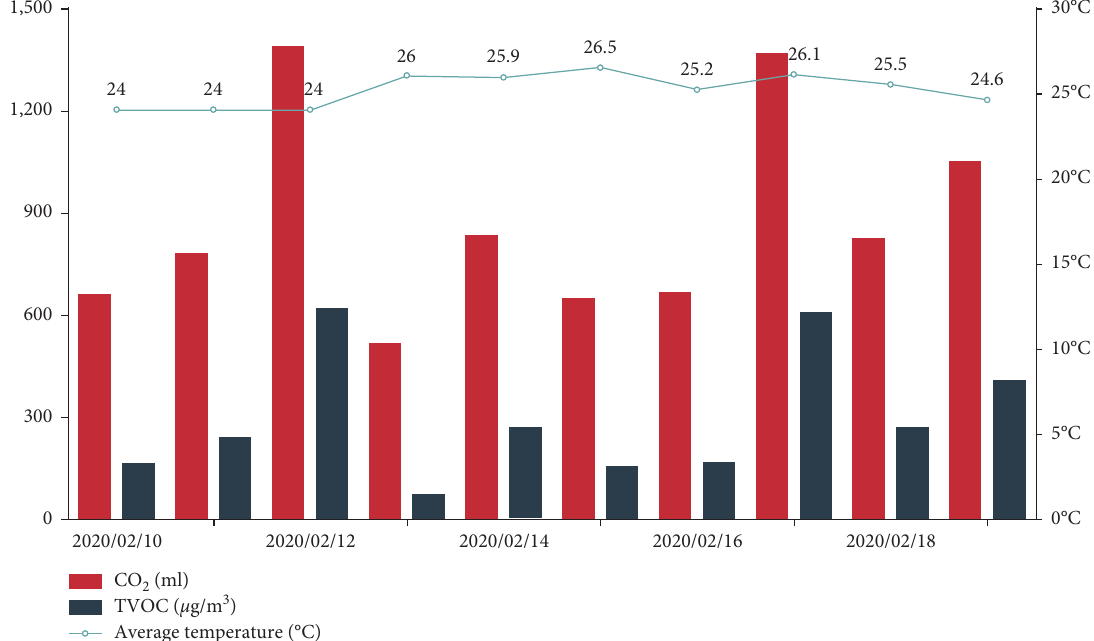
Figure 9: Trend of average temperature, CO